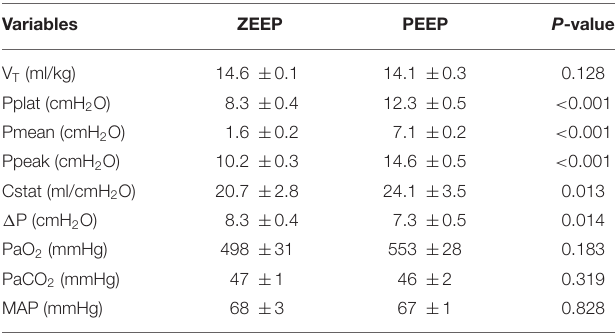
TABLE 1 | Respiratory system mechanics, mean arterial blood pressure (MAP), and arterial blood gases were measured in 6 anesthetized and